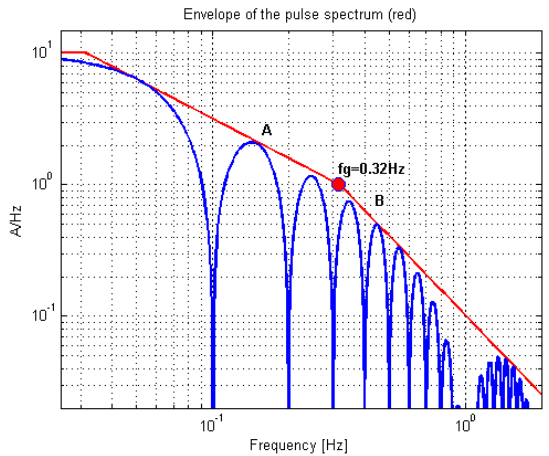
Figure 6. Logarithmic graph of modulus of trapezoidal pulse transform I p2 ( ω ,10 1 ,1). A—envelope I p0 ( ω ,10), B—rest of trapezoidal pulse envelope.